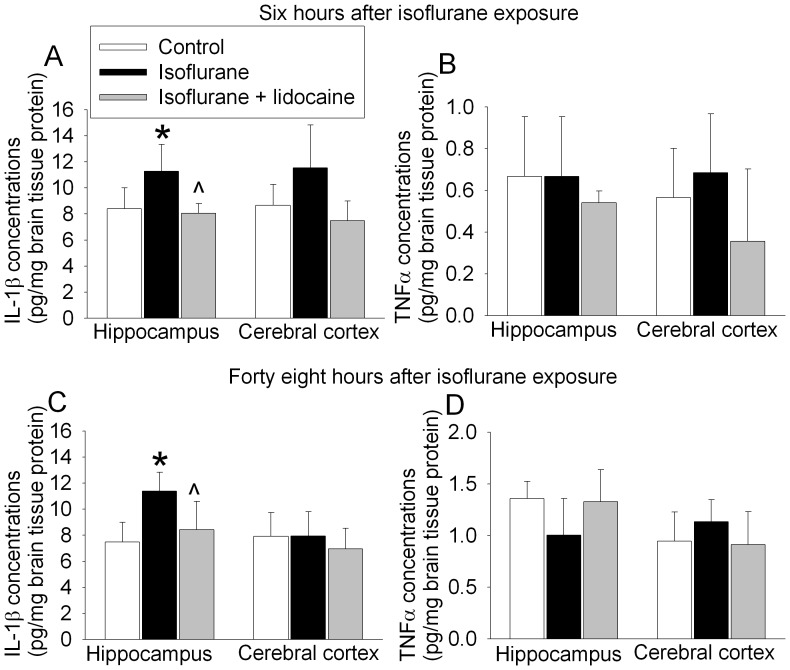
Isoflurane effects on interleukin 1β (IL-1β) and tumor necrosis factor α (TNFα) contents in rat brain tissues.A and B: eighteen-month-old Fisher 344 rats were exposed to or were not exposed to 1.2% isoflurane in the presence or absence of lidocaine for 2 h. Hippocampus and cerebral cortex were harvested at 6 h after anesthetic exposure for ELISA of IL-1β or TNFα content. C and D: eighteen-month-old Fisher 344 rats had training sessions of fear conditioning test and 30 min later were exposed to or were not exposed to 1.2% isoflurane in the presence or absence of lidocaine for 2 h. Hippocampus and cerebral cortex were harvested at 48 h after anesthetic exposure for ELISA of IL-1β or TNFα content. Results are means±S.D. (n = 4). *P<0.05 compared to control. ? P<0.05 compared to isoflurane alone. Statistical analysis was performed by one-way analysis of variance.